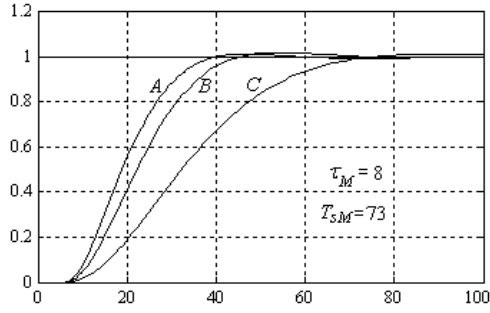
Figure 15. Responses y ( t ) to a unit step reference for: (A) K M = 2, K = 6; (B) K M = 1.5, K = 2.4; (C) K M = 1, K = 0.5.